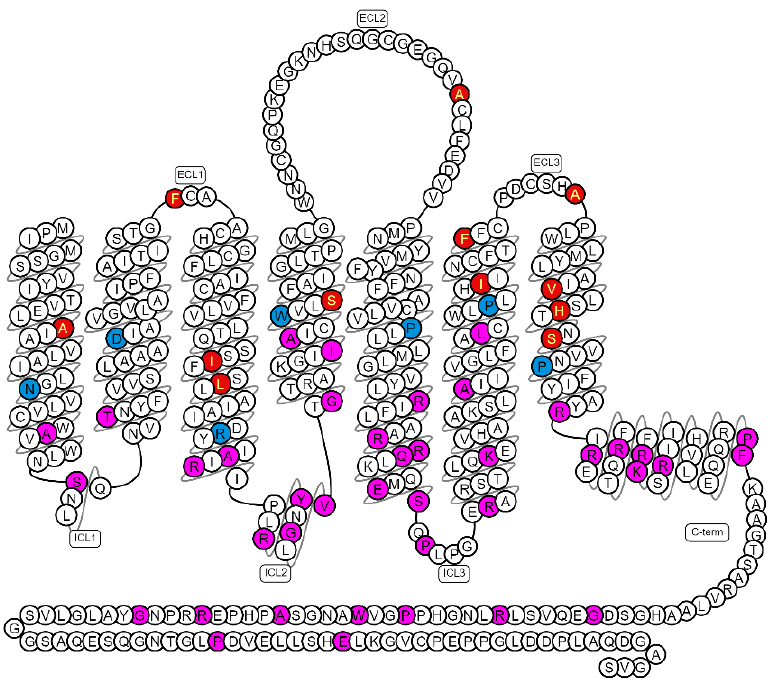
Figure 1. Snake plot showing the primary structure of wild-type human A 2A AR. Blue: the most conserved *. 50 residues at each helix (Ballesteros–Weinstein numbering system). Red: residues with cancer-associated mutations in the upper part of the receptor (P 7.50 is labeled in blue, where mutation P285L 7.50 was identified). Magenta: residues with cancer-associated mutations in the lower part of the receptor. This figure was derived from GPCRdb.org